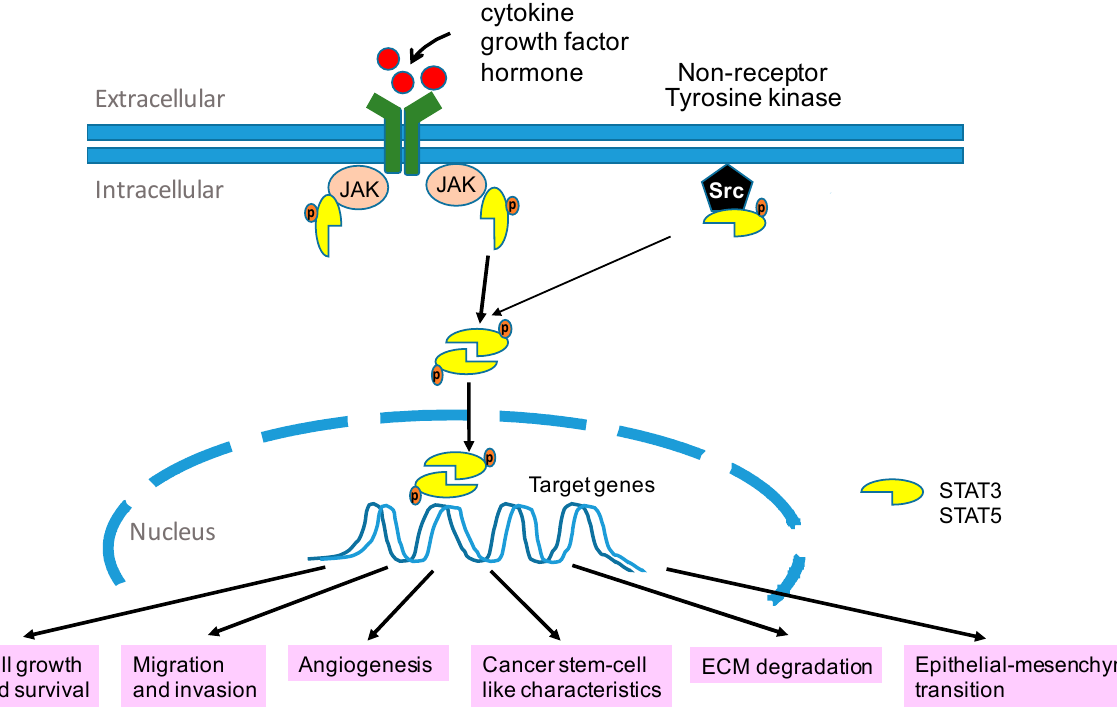
Figure 3. Activator of transcription 3 (STAT3)/5 signaling pathway. Activation of STAT3/5 promotes target gene expression, which contributes to tumor growth, survival, invasion, angiogenesis, stem cell-like characteristics, extracellular matrix (ECM) degradation and epithelial-mesenchymal